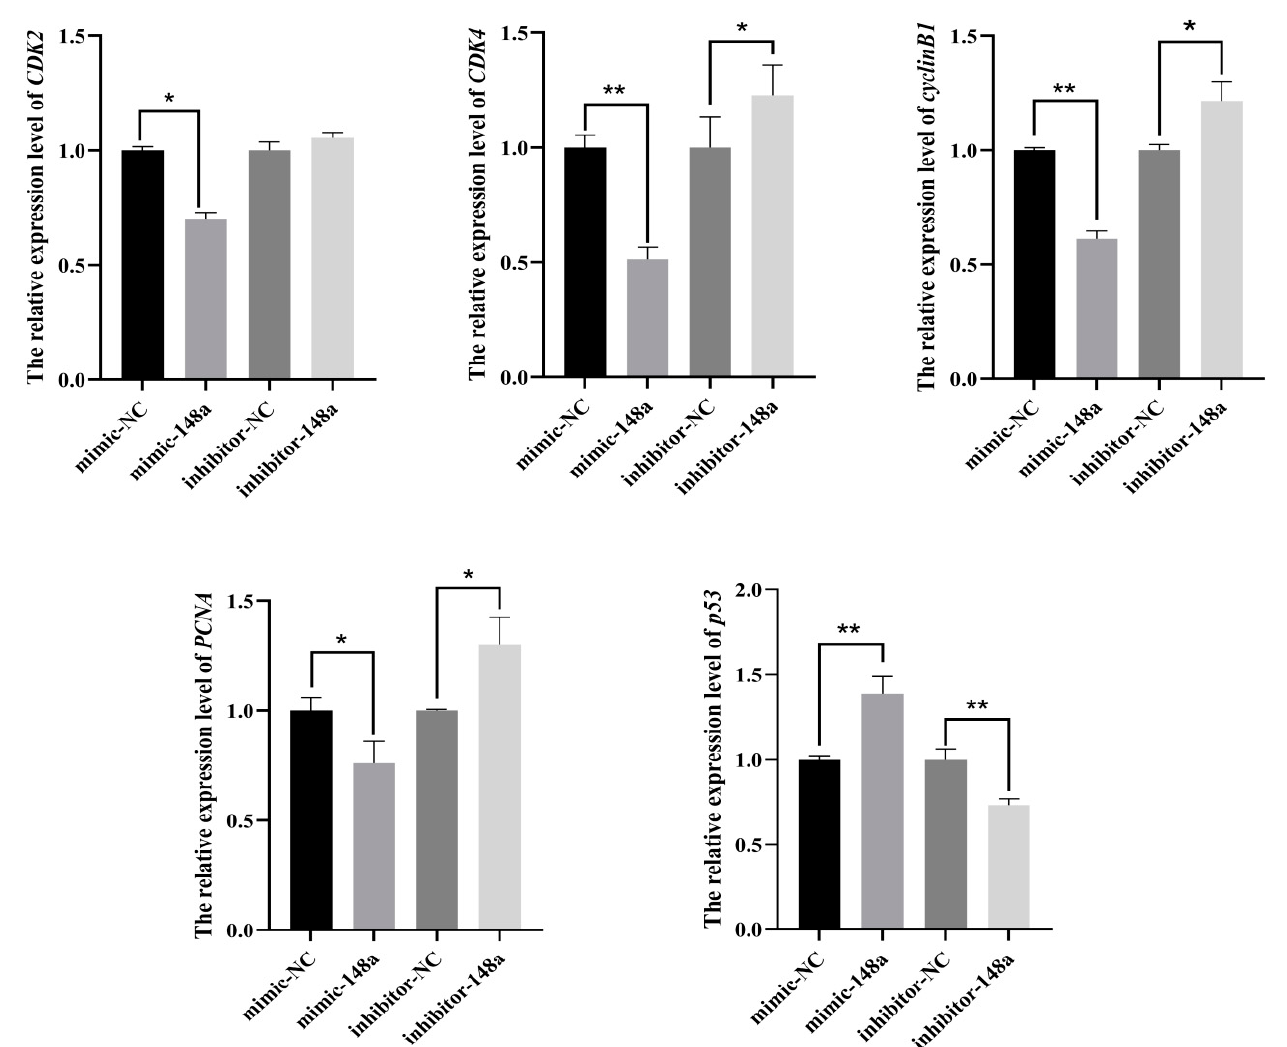
Figure 5. The miR-148a suppressed ovine preadipocyte proliferation. The expression levels of CDK2 , CDK4 , cyclinB1 , PCNA and p53 were detected when the miR-148a mimic, miR-148a inhibitor and NC were transfected into ovine preadipocytes. The results are depicted as the mean ± SD ( n = 3), * p < 0.05, ** p < 0.01.